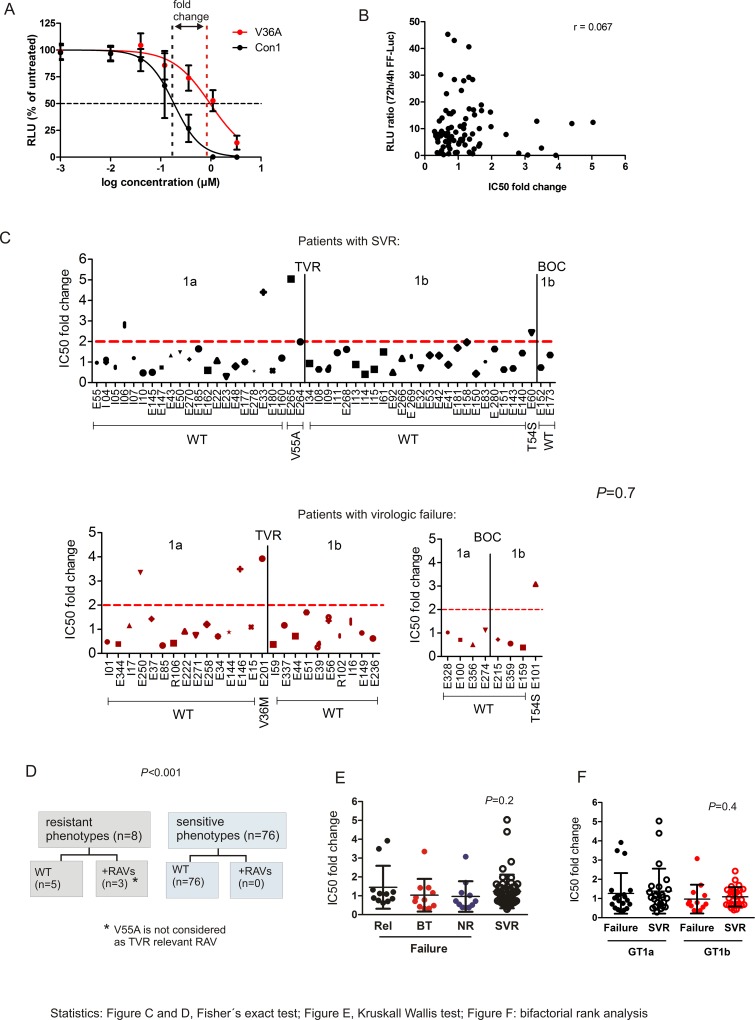
BOC/TVR sensitivity of baseline NS3 protease subgenomic HCV replicon libraries.A) Exemplary representation of IC50 value determination and fold change calculation using titration curves of the wildtype GT1b reference strain (Con1) and the corresponding strain with the low level resistance-conferring RAV V36A. B) Representation of the replication fitness of NS3 subgenomic HCV replicons which is defined as the 72h/4h luciferase ratio relative to the apparent drug sensitivity expressed as fold change of the IC50 value. (c) Sensitivity of single phenotypes in correlation with RAVs and outcome of infection. (d) Association of phenotype sensitivity with RAVs. (e) Phenotype sensitivity after subgrouping of virologic failure samples by relapse (Rel.), breakthrough (BT) and non-response (NR) in comparison to SVR. (f) Subgrouping of NS3 phenotypes according to the viral subtype.